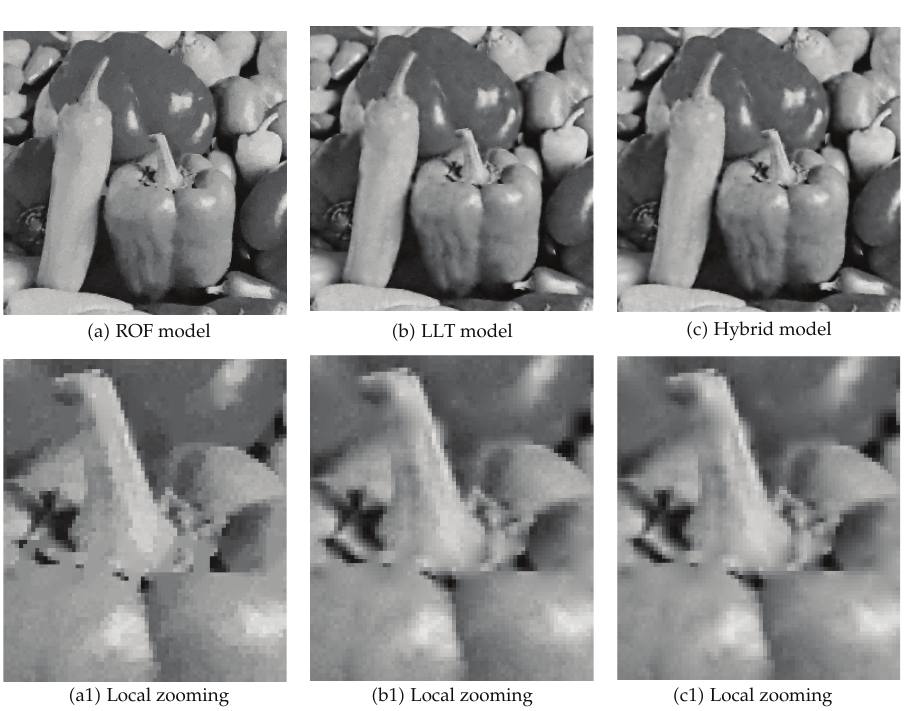
Figure 7: The related restored images corresponding to the noisy image in Example